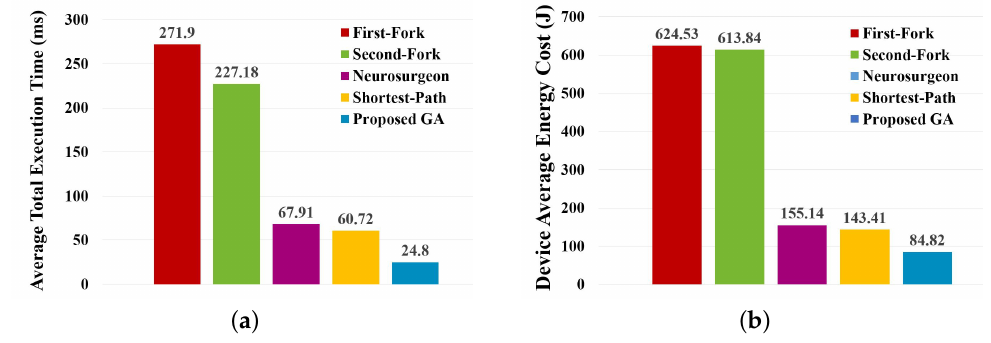
Figure 5. Performance comparison on partitioning B-AlexNet by considering partitioning and deploying separately. ( a ) Comparison on average total execution time. ( b ) Comparison on device- average energy